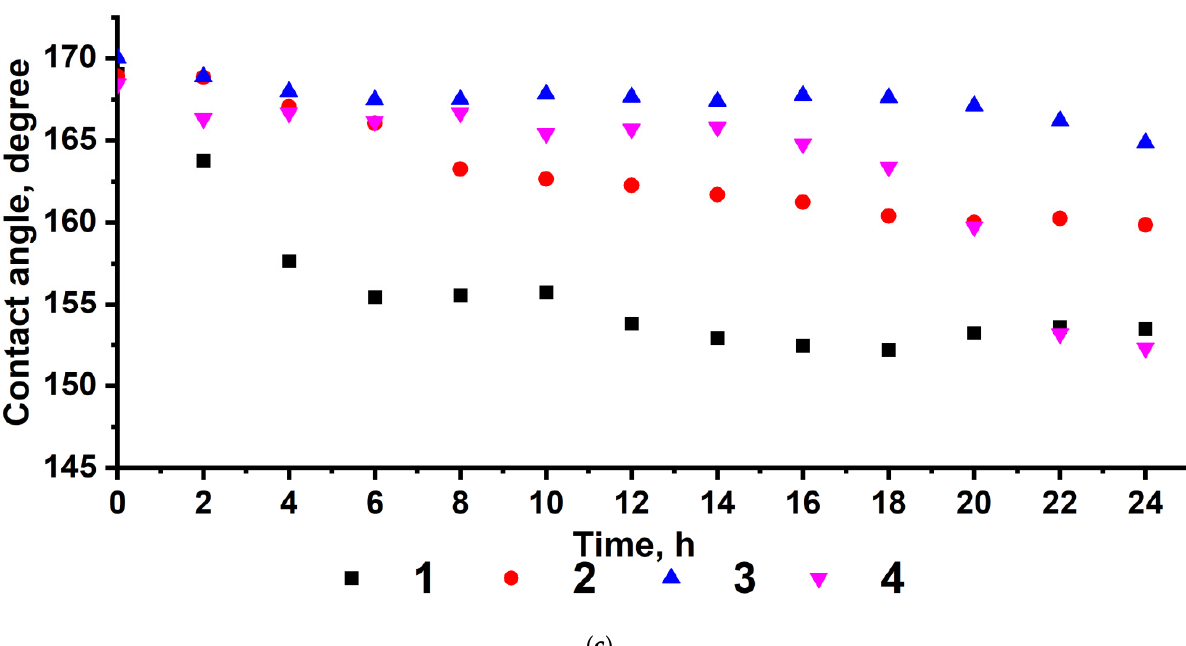
Figure 4. Change in wetting angles from the time of contact of a water droplet with the textured aluminum surface modified with ( a ) poly-(TEMA-co-GMA); ( b ) poly-(HIMA-co-GMA); and ( c ) poly-(HBMA-co-GMA) with varying FMA contents of the copolymer (theoretical FMA contents are as follows: 1—33%; 2—50%; 3—66%; 4—100%).